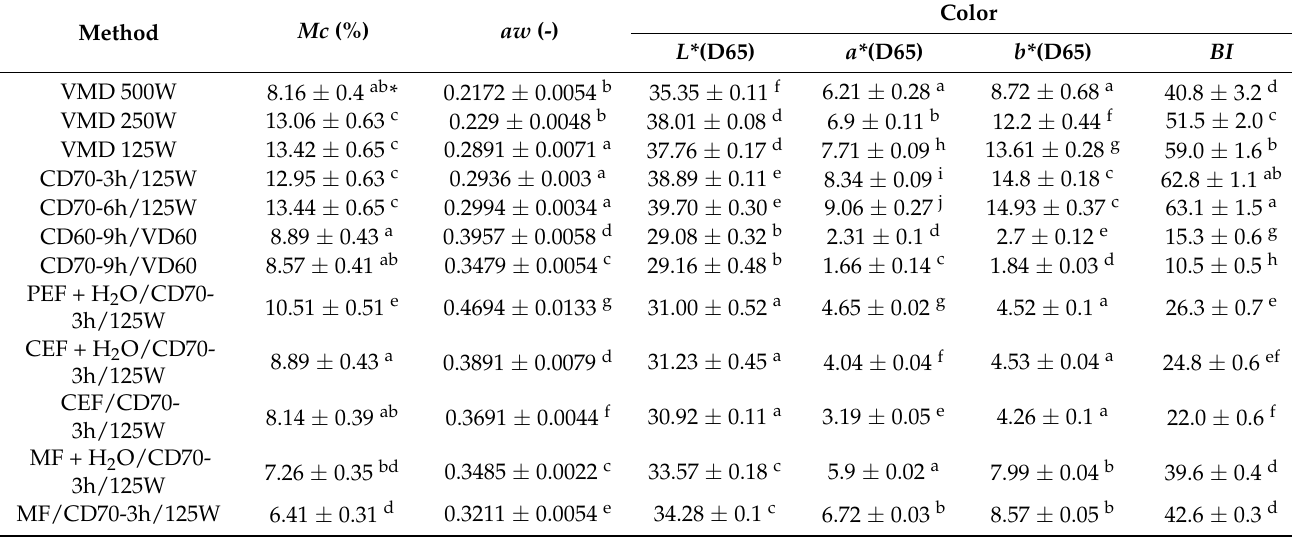
Table 1. Water activity ( aw ), moisture content ( Mc ), and color (CIE L*a*b* , browning index— BI ) of black garlic powders after nonthermal treatments and